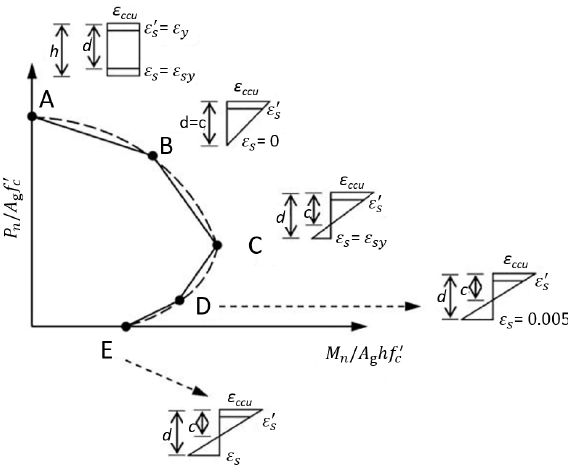
Figure 1. Simplified interaction curve [7].